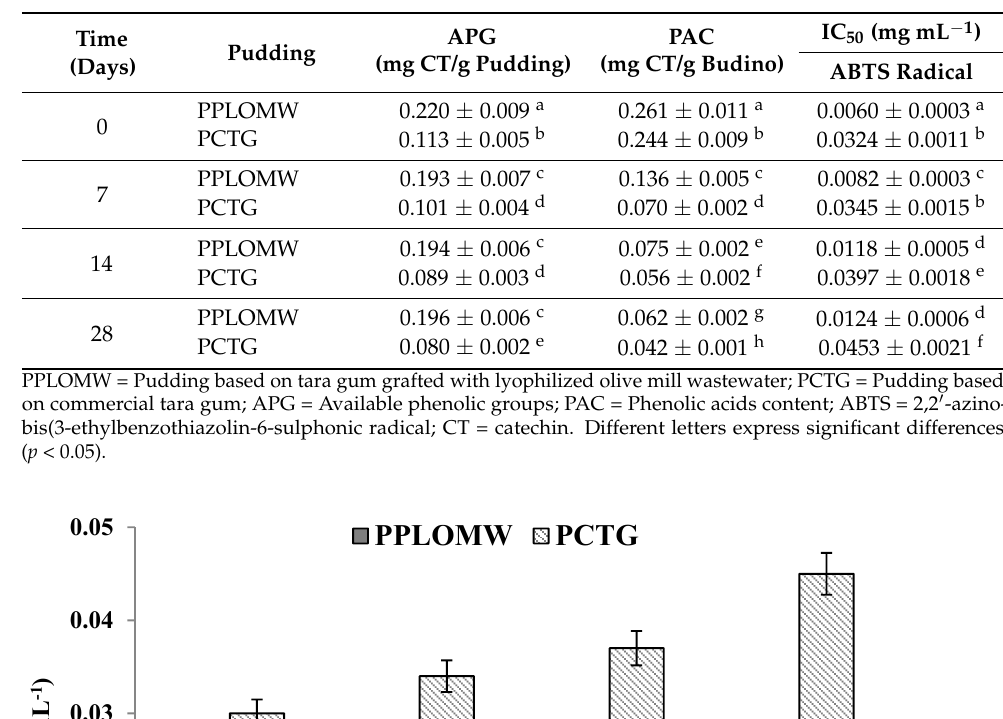
Table 6. Total polyphenols, phenolic acid contents and antioxidant activity of puddings based on PLOMW and CTG. Data represent mean ± RSD ( n = 3).